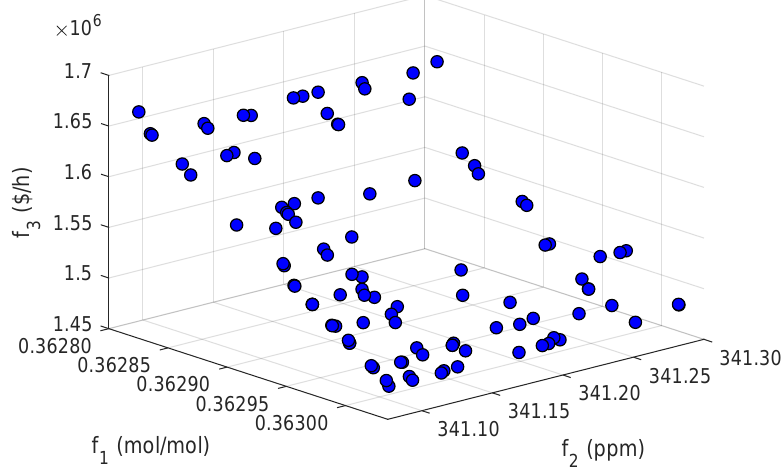
Figure 4. Pareto-optimal frontier for the three-objective optimization problem.